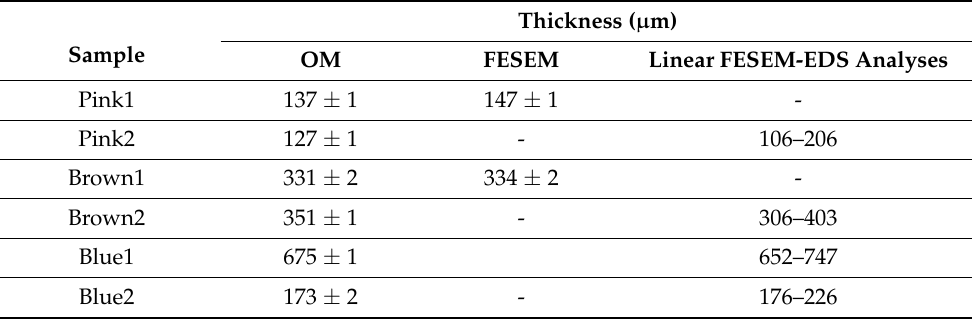
Figure 2. OM images of the colored layers on the flashed glasses in cross-section. Colored layer ( top ) and base glass ( bottom ). All the samples have the same scale. Table 1. Thickness of the colored layers measured in the cross-section of the glasses using OM, FESEM, and chemical linear analyses with